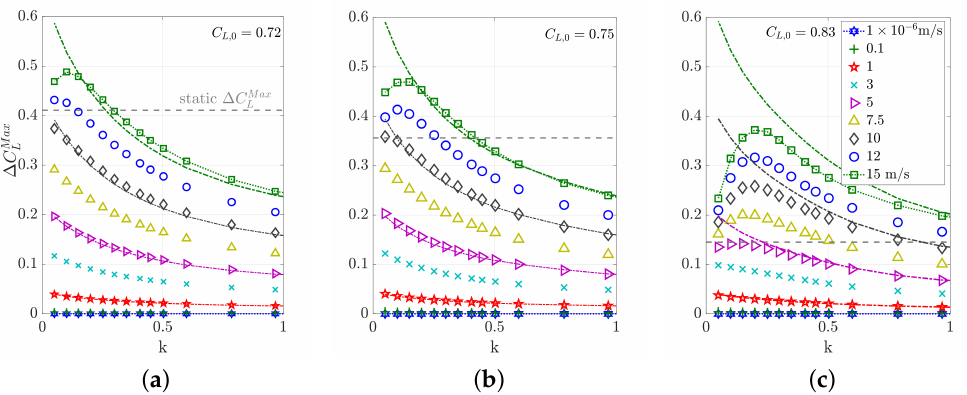
Figure 11. Maximum lift increment during one period of excitation. ( a ) Mach 0.66, ( b ) Mach 0.68, ( c ) Mach 0.72.